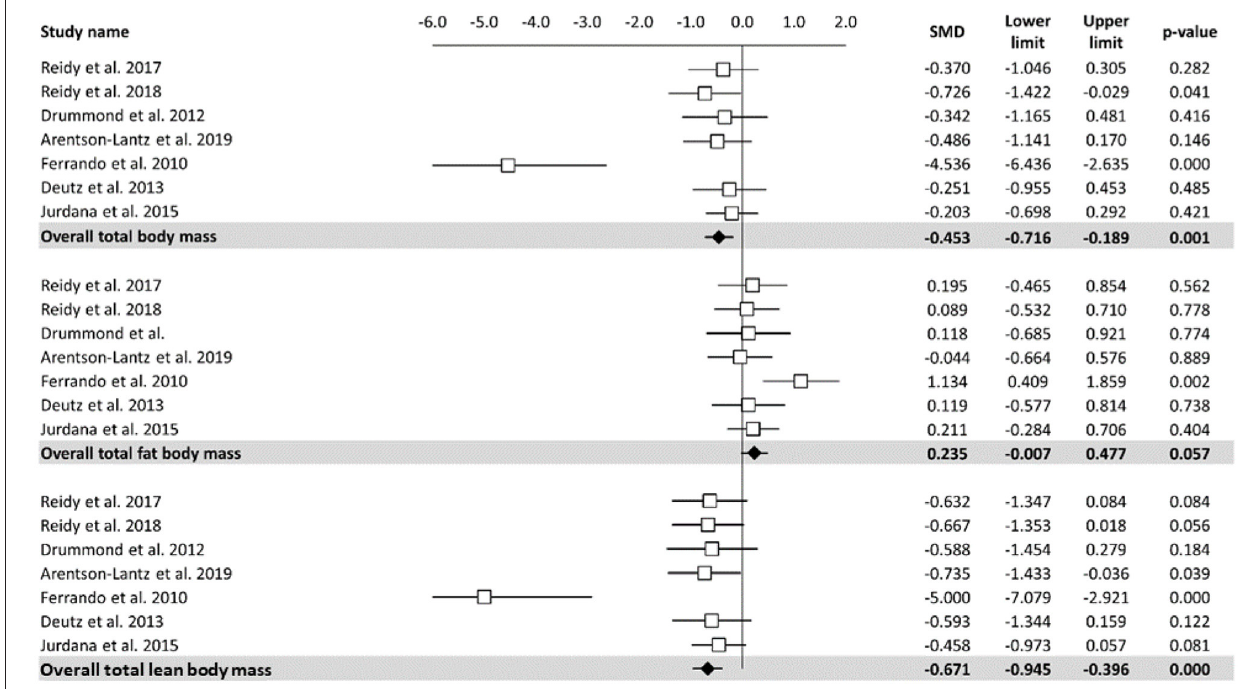
FIGURE 2 | Effects of bed rest on body composition. The results are displayed separately for total, fat, and lean body mass and data expressed as percent differences from the baseline. Mean values and 95% CI are reported for each study as squares and thin line, respectively. Summary results for each parameter are described as solid diamond and thin lines on the gray background. The figures, with P -values, are reported on the right part of the plot.